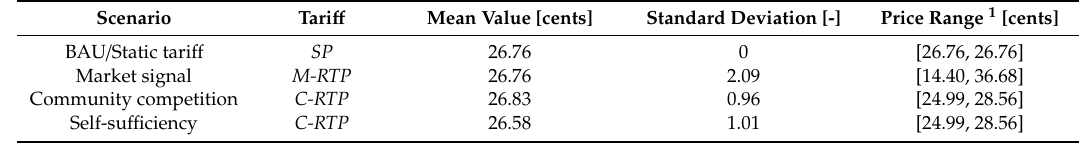
Table 6. Scenario-specific statistic values of electricity tari ff